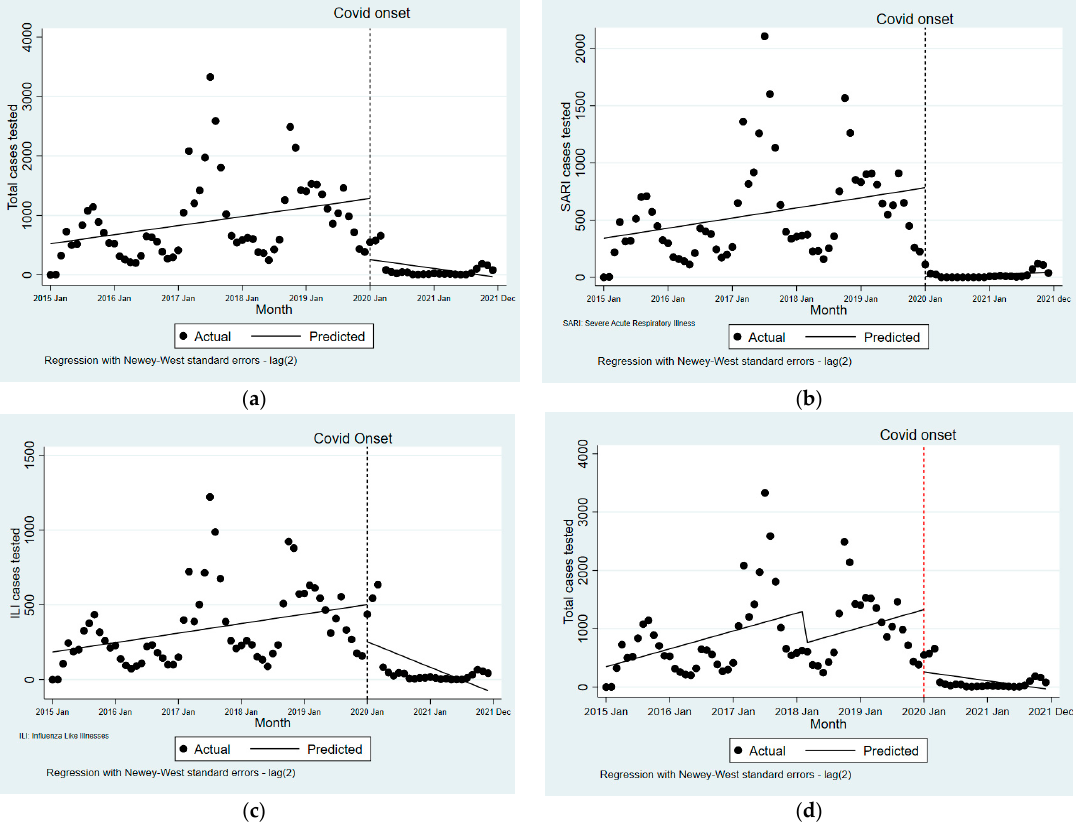
Figure 3. Interrupted time series showing the unadjusted and adjusted linear trend in the number of samples tested for influenza (stratified by ILI and SARI) each month at MIV, Karnataka, India during Pre-COVID-19 (segment-1) and COVID-19 periods (segment-2). ( a ) Total samples tested; ( b )